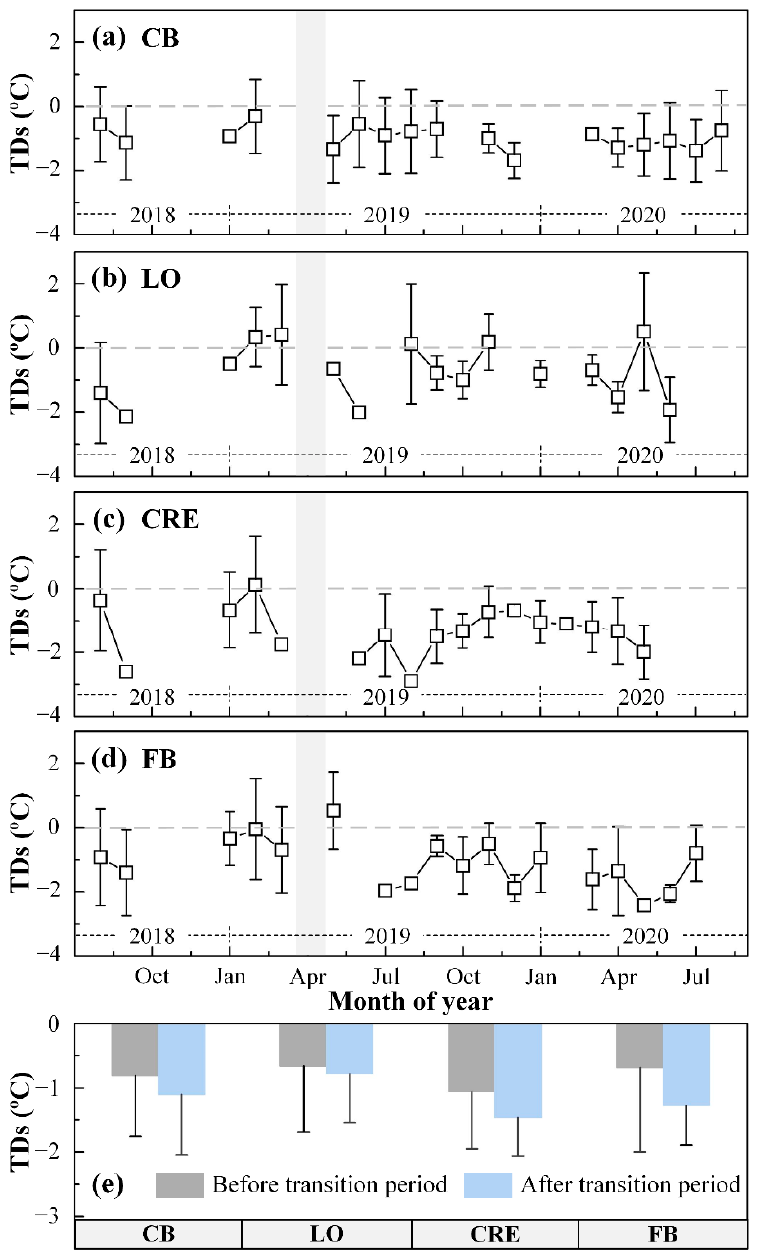
Figure 3. Mean monthly temperature differences (TDs) and standard deviations (STDs) between ECOSTRESS SST and in situ SST from the matching pairs found between August 2018 and August 2020 for ( a ) CB, ( b ) LO, ( c ) CRE, and ( d ) FB. The gray bars indicate the transition period when ECOSTRESS changed its data collection method. Data gaps are due to lack of matchup data pairs; The summary of TDs and STDs for each estuary or lake is shown in ( e ), with data separated by the transition period.